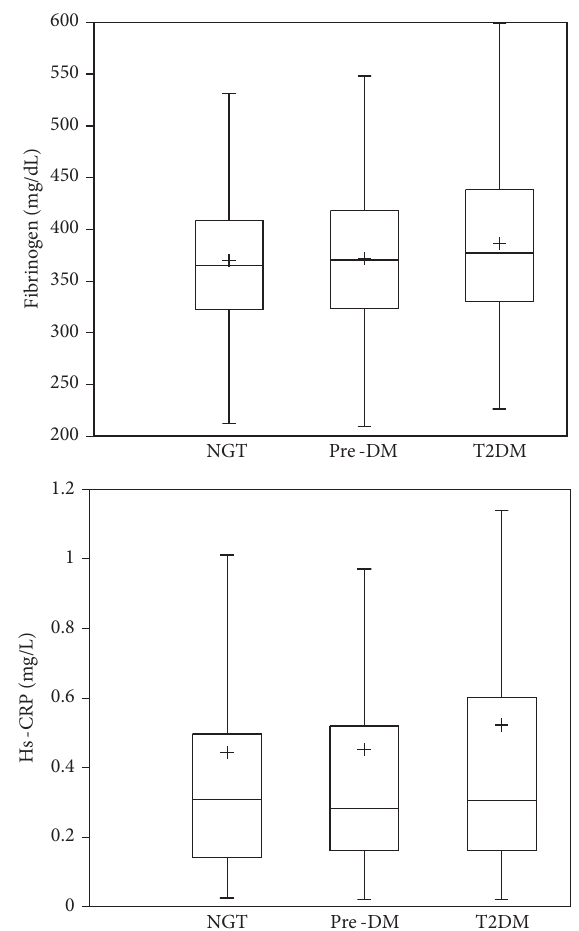
Figure 2: Box plots showing plasma levels of fibrinogen and hs-CRP according to glucose tolerance status. Fibrinogen showed significant difference between NGT and T2DM ( 𝑃 = 0.01 ), but it was not between NGT and pre-DM ( 𝑃 = 0.71 ). The hs-CRP concentration was statistically different between NGT and T2DM ( 𝑃 = 0.05 ), but it was not between NGT and preDM ( 𝑃 = 0.89 ). + =